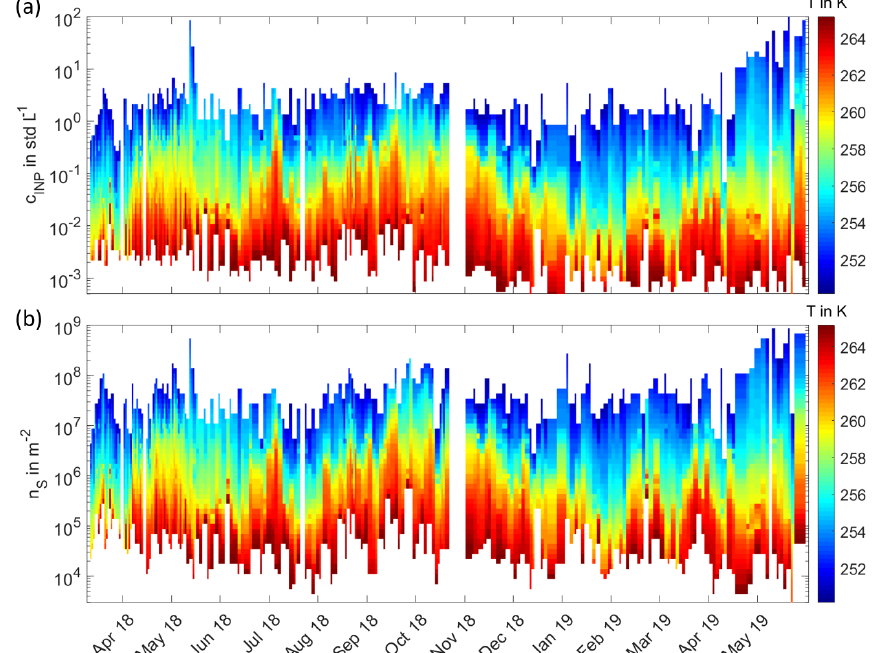
Figure 2. Long-term record of INPs from 11 March 2018 to 31 May 2019 in the Finnish boreal forest. Panel (a) shows the time series of INP concentrations c INP , with a general temporal resolution between 24 and 144h. The colour code indicates the corresponding activation temperatures in kelvin. In panel (b) , the time series of INAS densities n S is displayed in the same manner as for the INP concentrations in panel (a) .